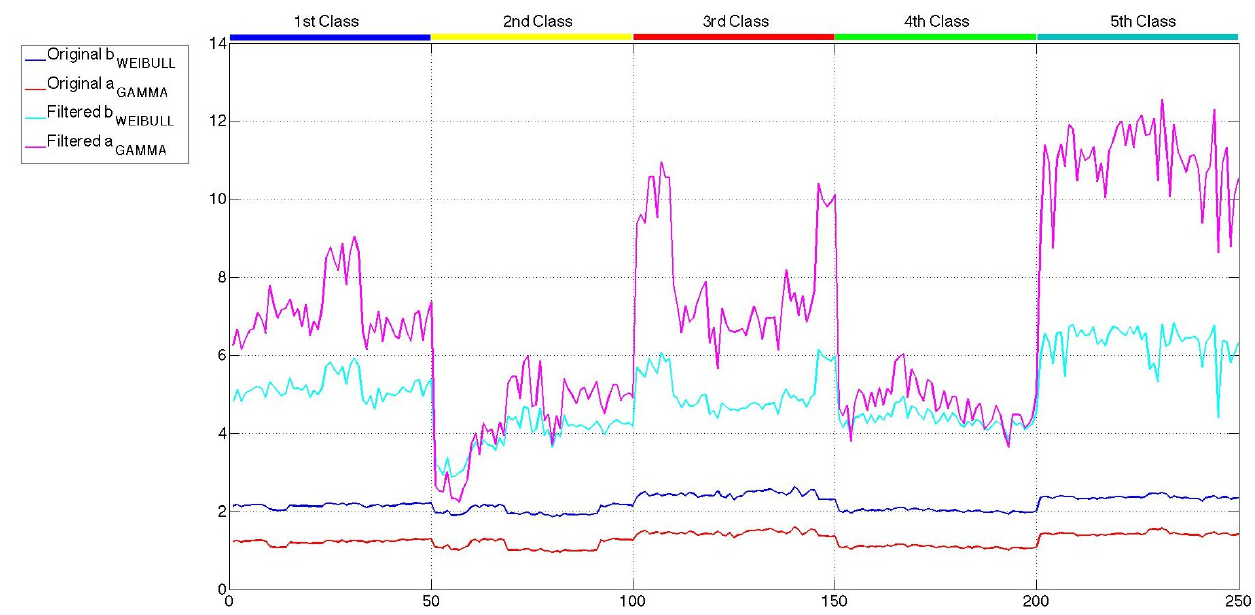
Figure 13. Comparison of the shape parameters of the gamma and Weibull distributions for original and mean shift-filtered